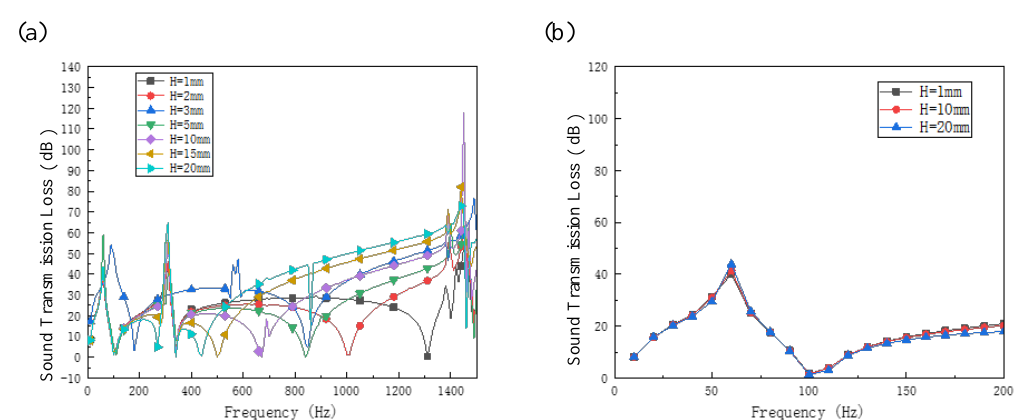
Figure 10. Effect of cavity thickness on STL for phononic crystals plate thickness of 1 mm: ( a ) 0 – 1500 Hz and ( b ) 0 – 200 Hz.